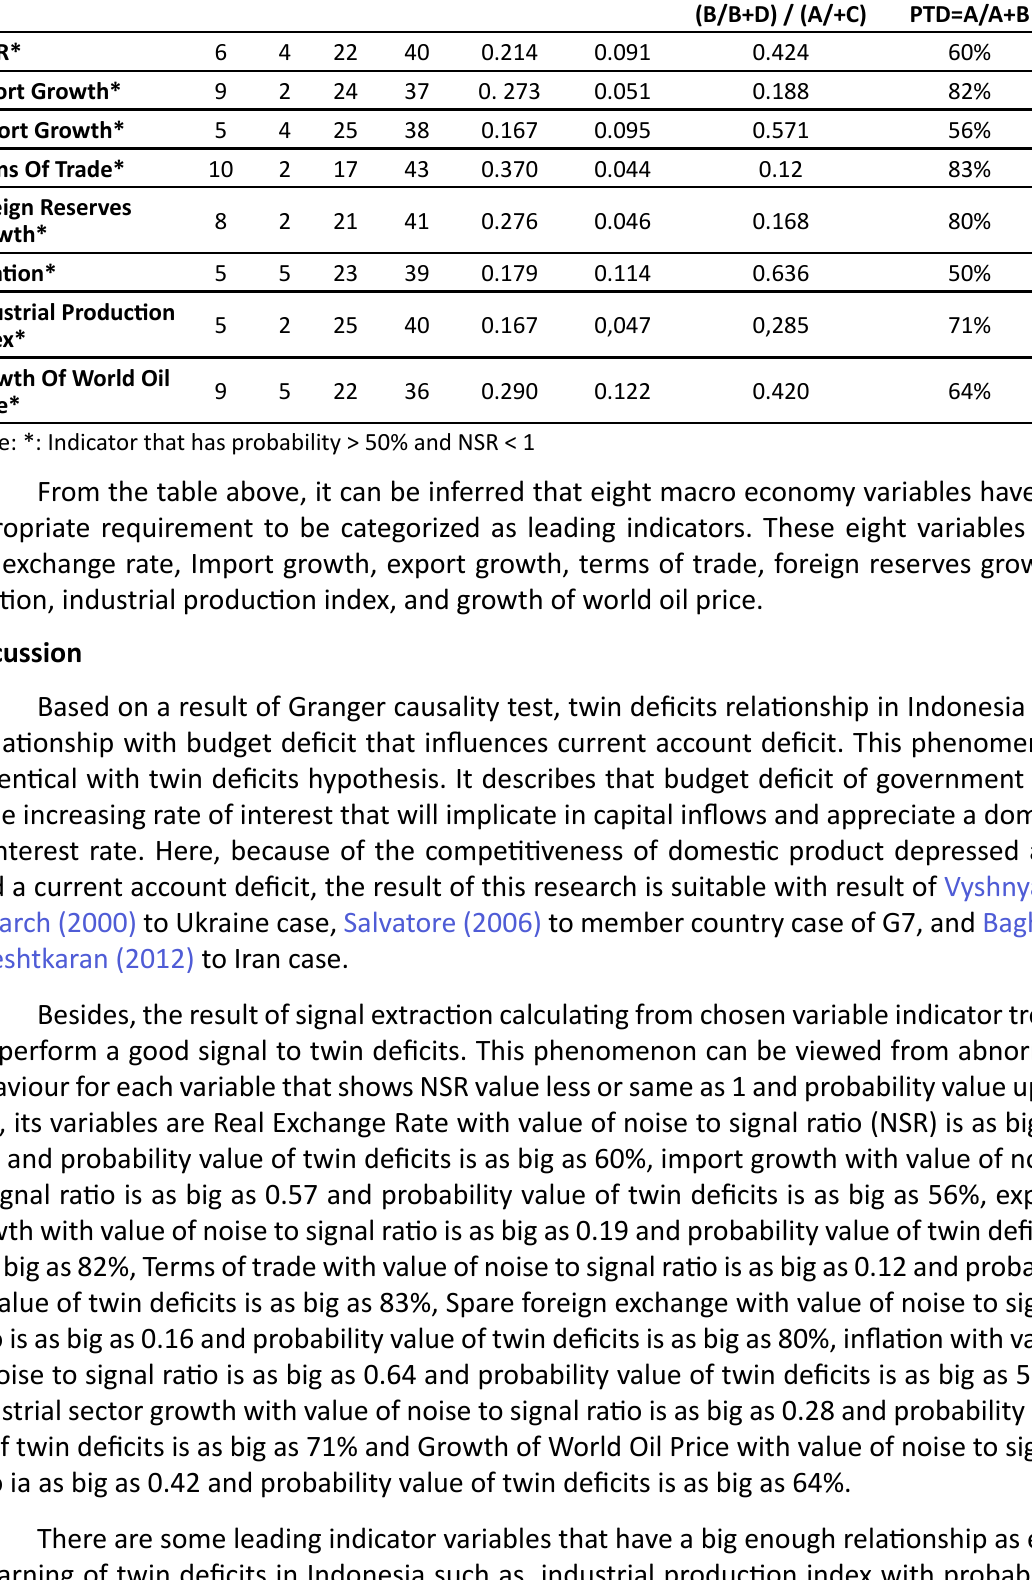
Table 5: Noise to Signal Ratio and Probability of Twin Deficits in Indonesia Table 3: Signal Matrix of Twin Deficits